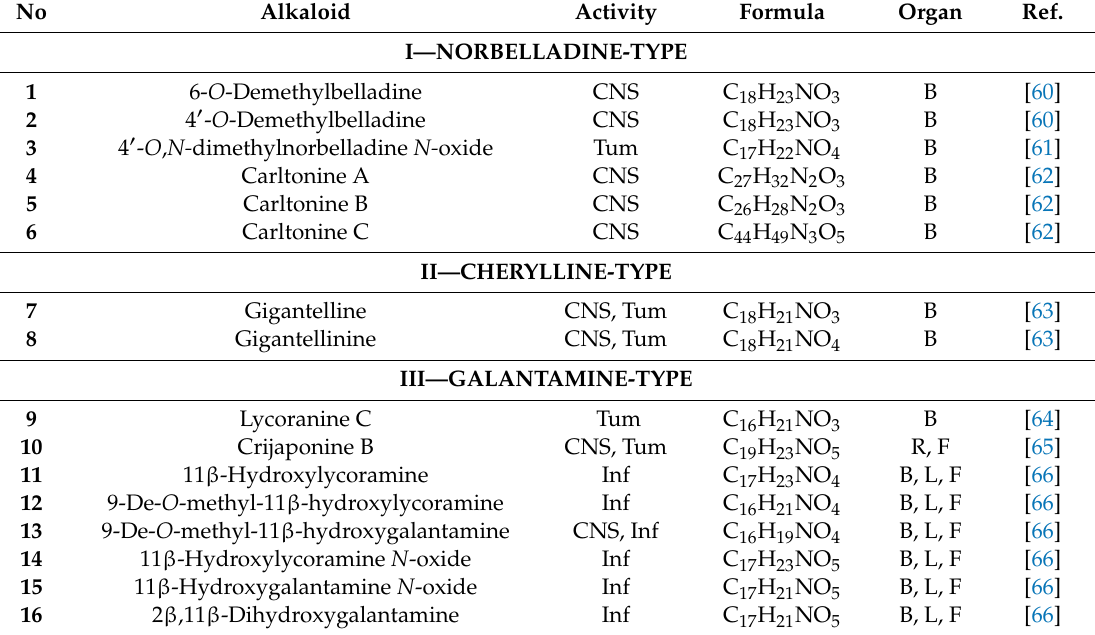
Table 2. Novel Amaryllidaceae alkaloids. Name, activity, chemical formula, and anatomic origin are displayed. The bold number in the first column corresponds to the assigned number of its corresponding chemical structure shown in Figures